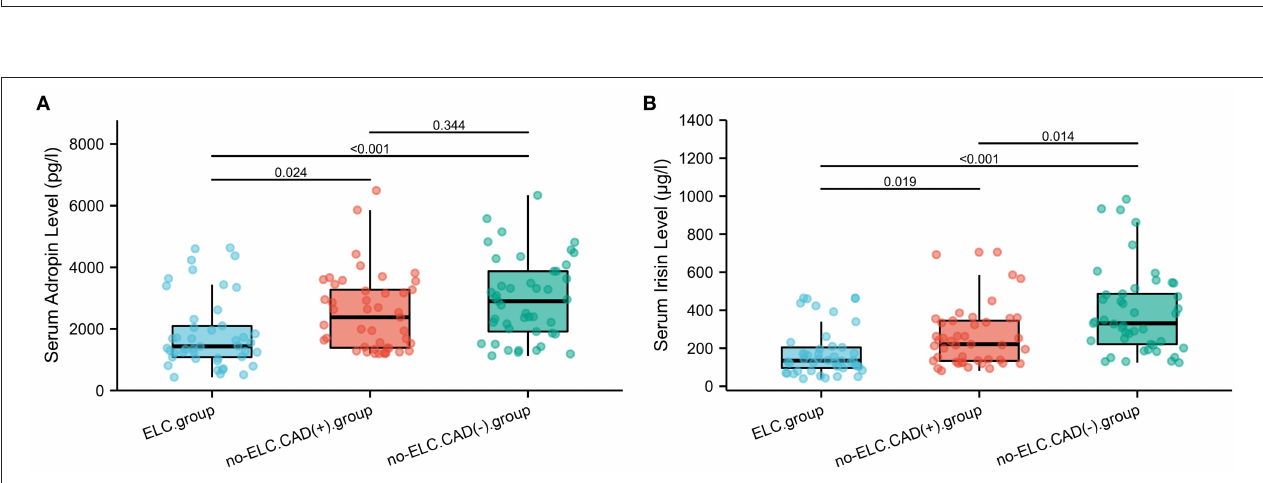
FIGURE 4 | (A,B) Comparison of serum adropin and irisin levels between enrolled patients with and without diagonal ELC. ELC, earlobe